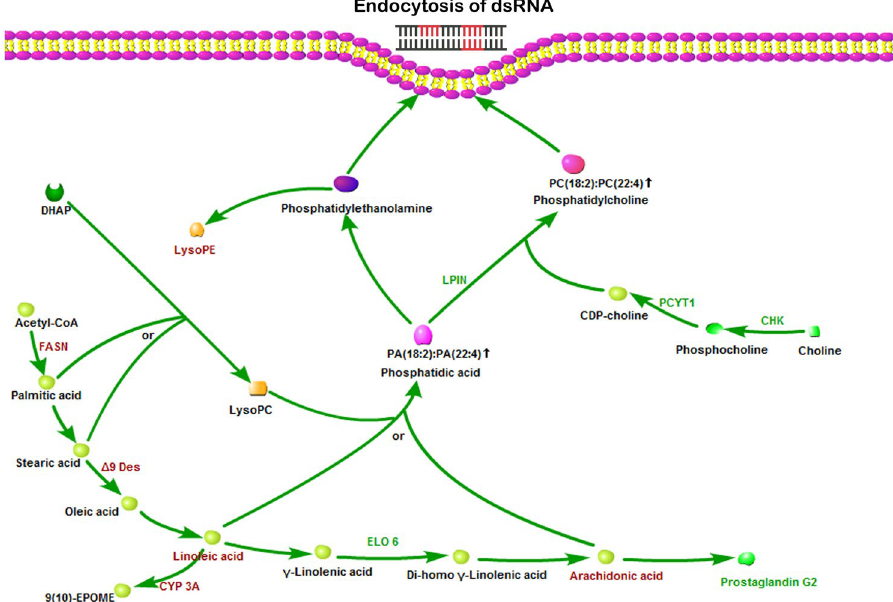
Figure 5. Schematic map of fatty acid biosynthesis and metabolism. Acetyl-CoA is the substrate for the the biosynthesis of plamitic acid, which is the precursor stearic acid and other fatty acids with longer carbon chains. Strearic acid can transform into oleic acid and LA after desaturation. LA is a precursor of AA. Both LA and AA can be esterified into phosphatidic acids which are the main substrates for the biosynthesis of the major cell membrane components, phosphatidylcholine and phosphatidylethanolamine. Notes in red and green colors denote up- or down-regulated genes, proteins and metabolites in the Ch group vs the Nv group,